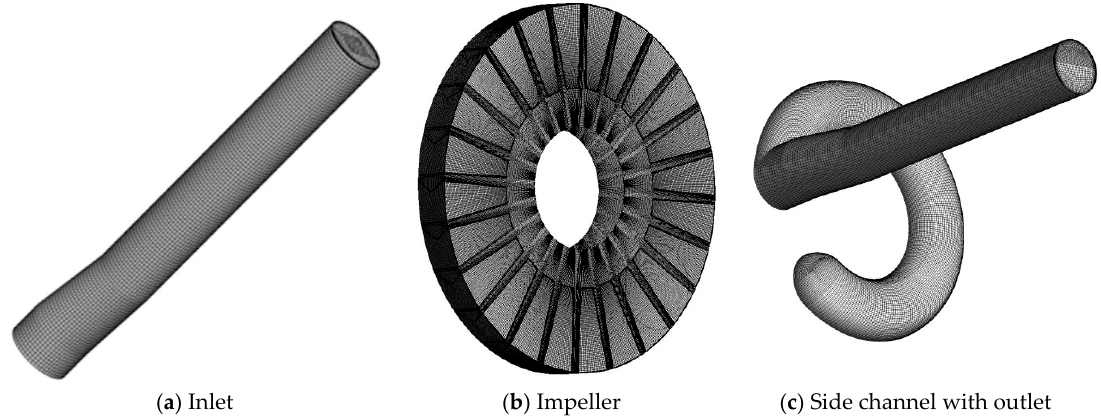
Figure 3. Structured computational flow domain grids.